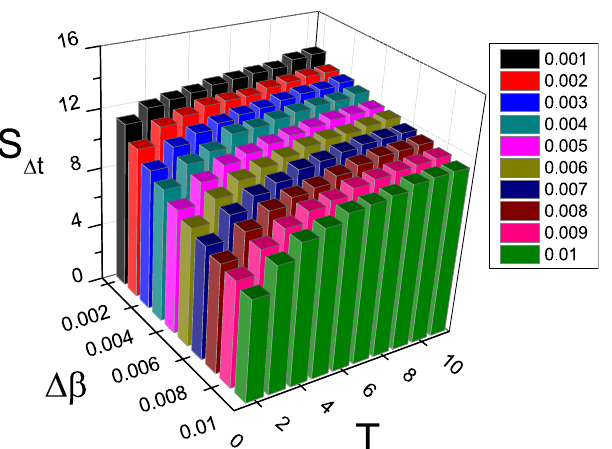
Figure 10. 3D plot of the dependence of S Δ t on the two parameters Δ β and T for the case of SF network where the other parameters are the same as in Fig. 9(c) and